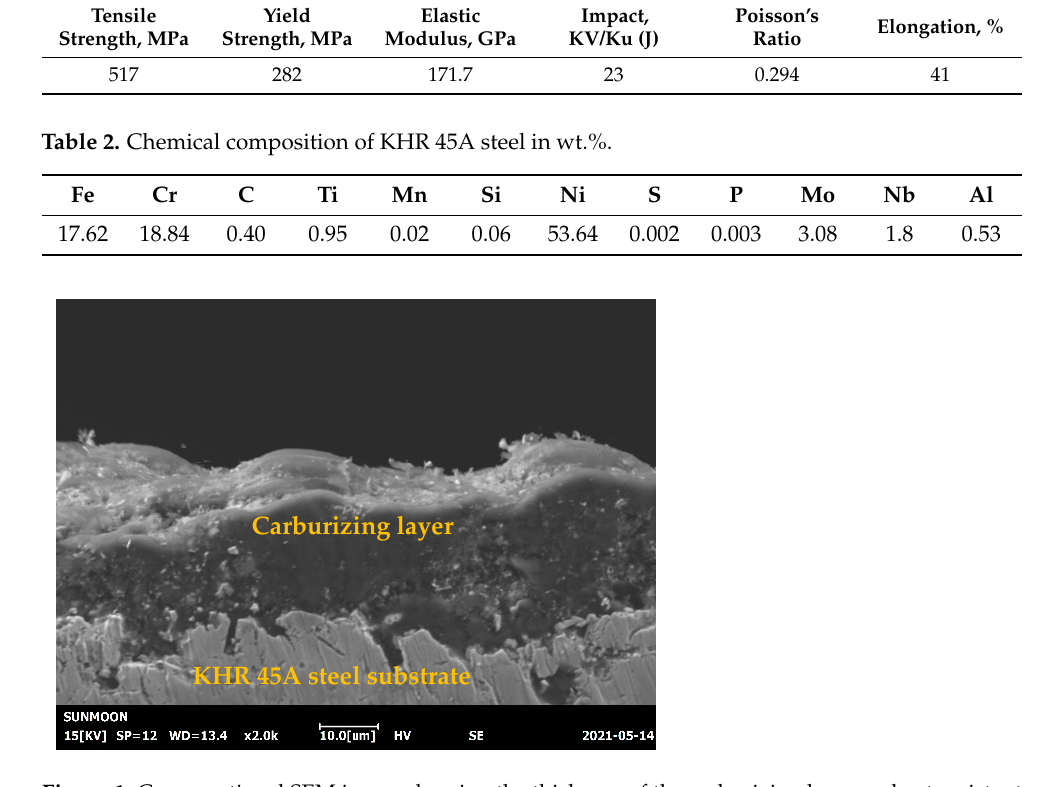
Figure 1. Cross-sectional SEM image showing the thickness of the carburizing layer on heat-resistant KHR 45A steel